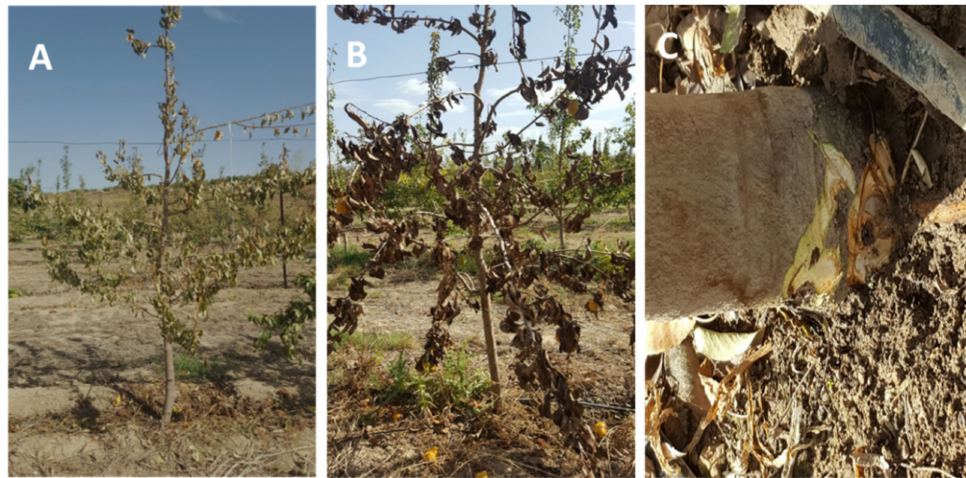
Figure 2. Decline disease symptoms such as yellowing ( A ), wilting ( B ), and brown lesions on the crown ( C ) on young pear tree sampled in the Sefrou location, Louata